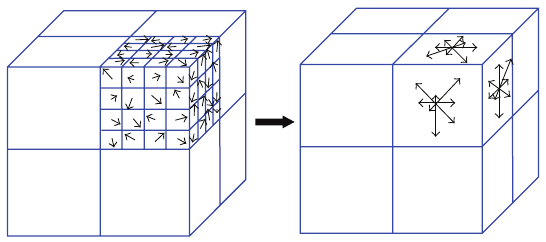
Figure 1: Orientation histogram of SIFT method.